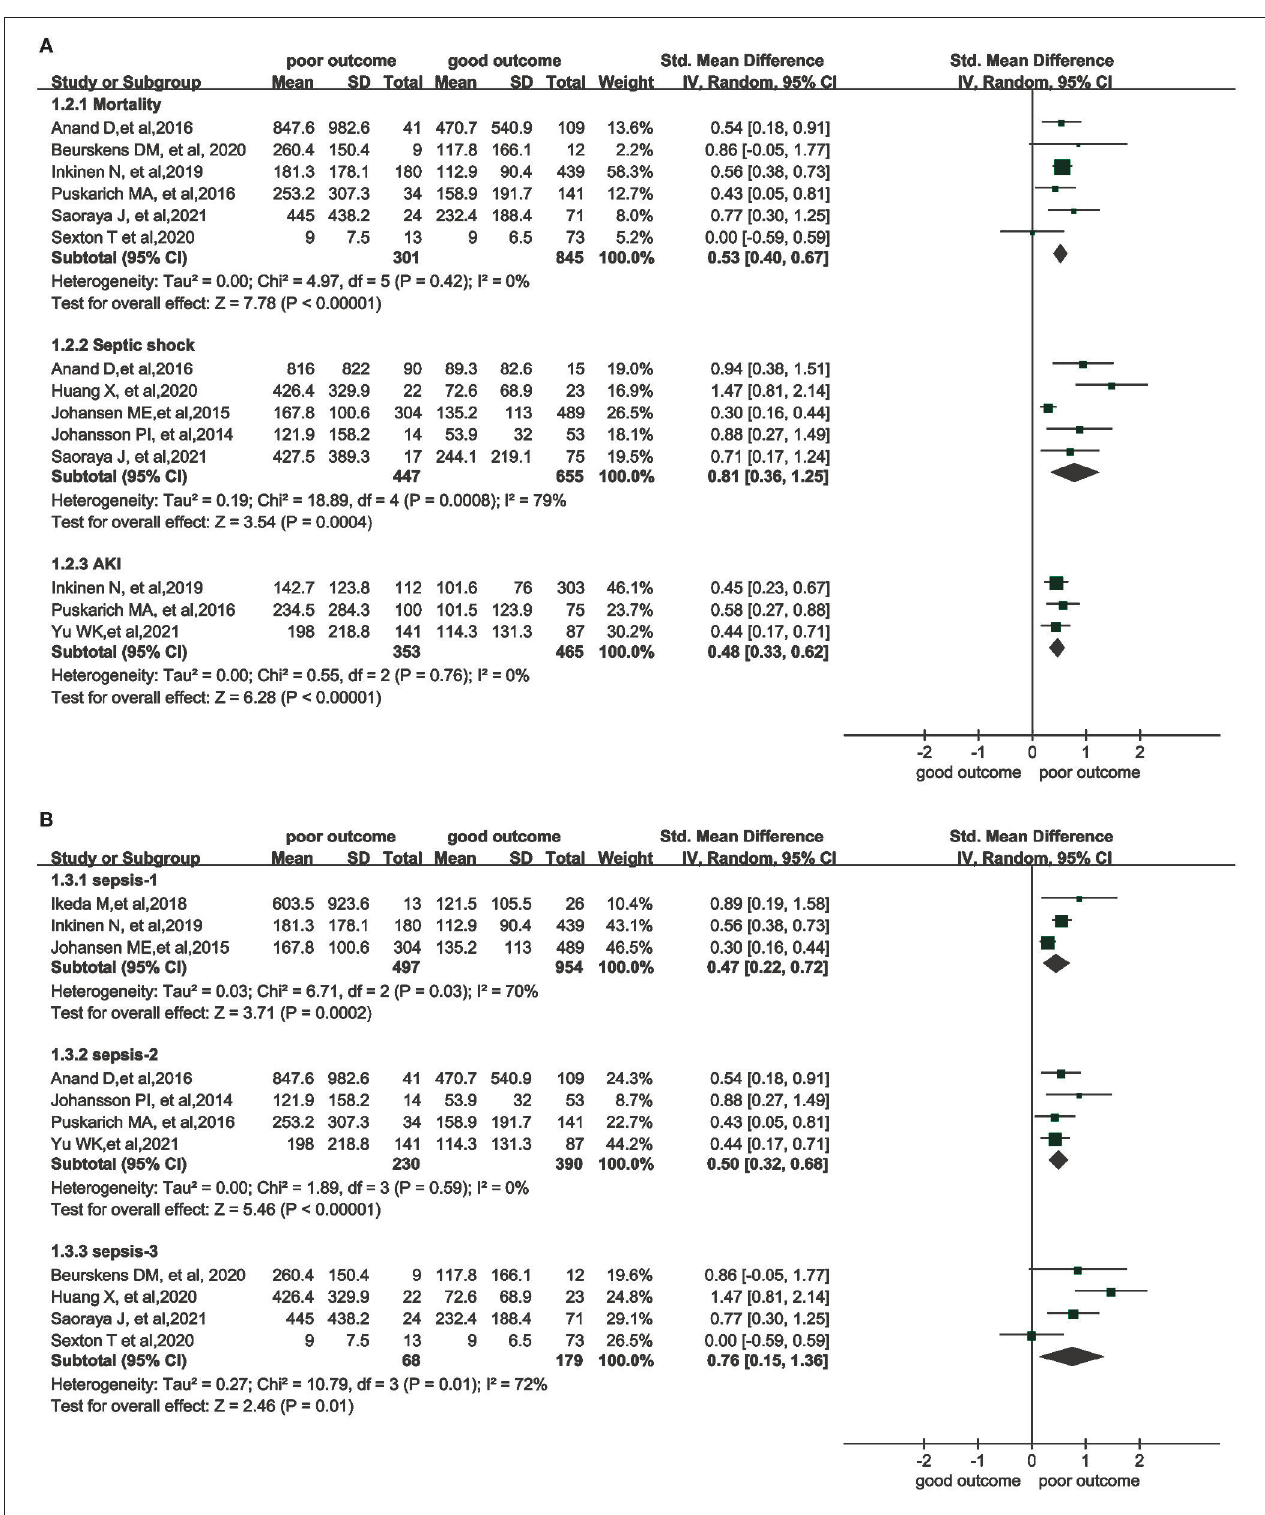
FIGURE 3 | Forest plots of subgroups. (A) Subgroup of complications and mortality; (B) Subgroup of three diagnostic criterias for sepsis.